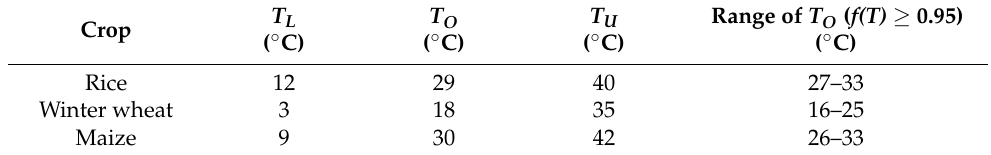
Table 2. Base ( T L ), optimum ( T O ) and maximum ( T U ) temperatures for crop photosynthesis [31]. T Crop